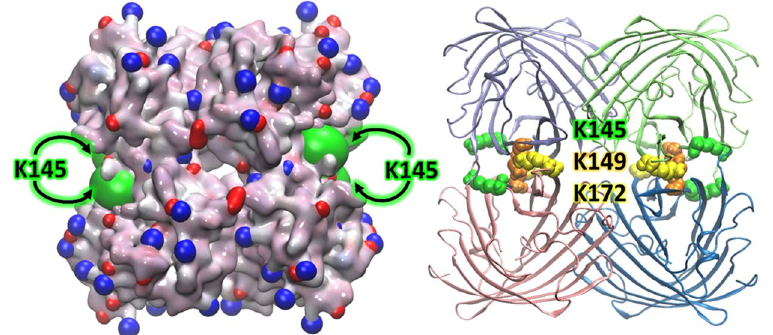
Figure 11. Charge distribution on the water-accessible surface (left) and the ribbon 3D model (right) of the SAASoti protein with highlighted lysine K145, K149 and K172. The model is based on the spatial structure of the Kaede protein. Negative (red) charges and positive charges (blue) are mostly paired at the surface of the tetramer structure. K145 lysine (green color in the left picture) is located in the cleft that is responsible for aggregation.